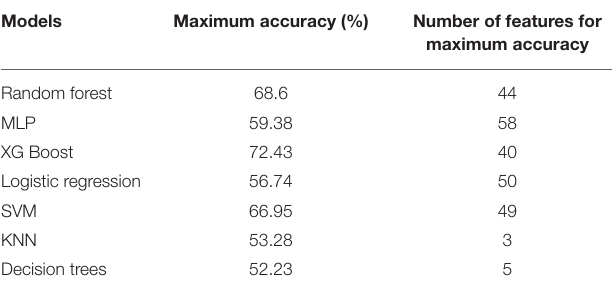
TABLE 3 | Maximum accuracy for classification methods.